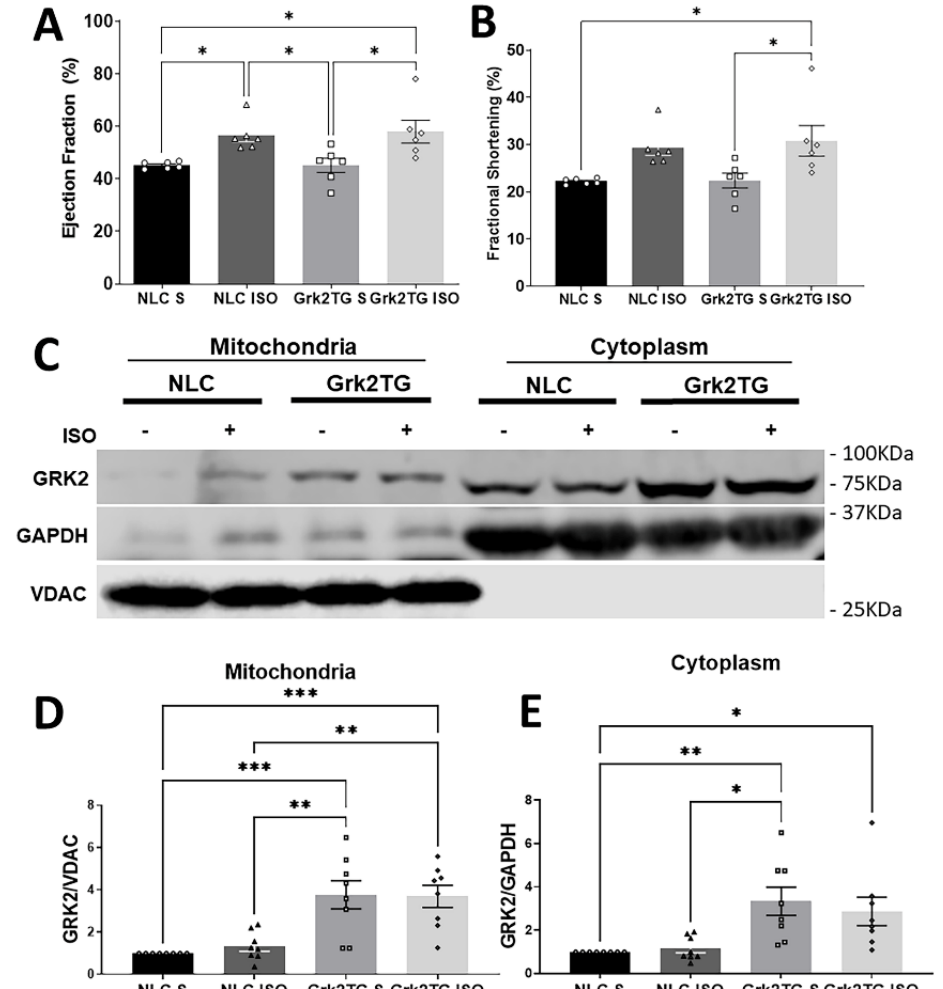
Figure 3. Chronic β AR stimulation and GRK2 levels in cellular compartments is altered in Grk2TG hearts ( A ) Left ventricular ejection fraction and ( B ) fractional shortening were measured by echocardiography ( n = 6 independent mice/group). ( C ) Representative immunoblots of GRK2 expression level in mitochondria (left) and cytoplasm (right). ( D ) Mitochondrial and ( E ) cytosolic GRK2 protein quantification ( n = 8 independent mice/group; mean ± SEM; * p < 0.05, ** p < 0.01, *** p < 0.005).